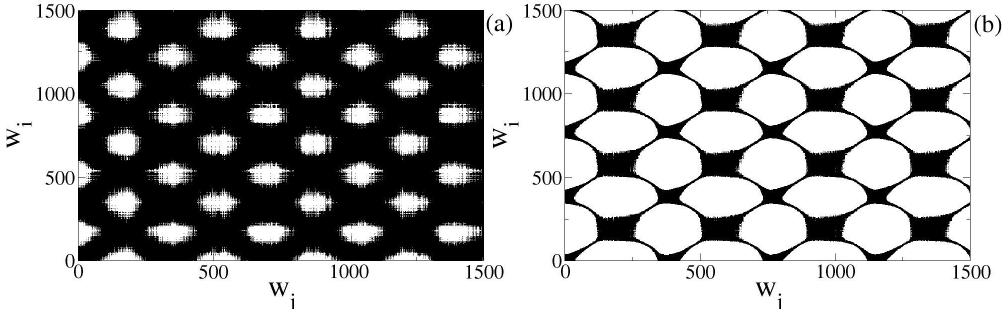
Figure 5. Mean field of the network described by Equation (4) for the scale-free network in panels ( a ), ( b ), and ( c ) and the small-world network in panels ( d ), ( e ), and ( f ). Here, the coupling values considered are the same as in Figure 4, where ( a ) and ( d )— ε = 0.002, ( b )— ε = 0.005, ( c ), and ( f )— ε = 0.040 and ( e )— ε = 0.011. The phase synchronized states ( c ) and ( f ) depict the higher amplitude of oscillations related to the bursting frequency.